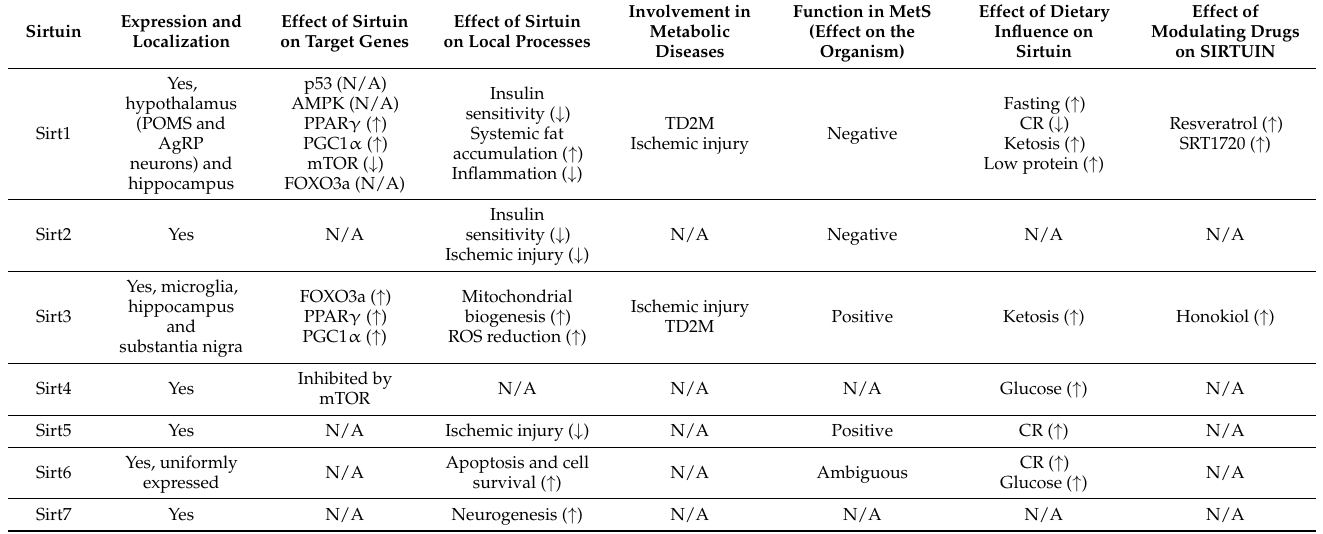
Table 3. Overview of the role of Sirtuins in the